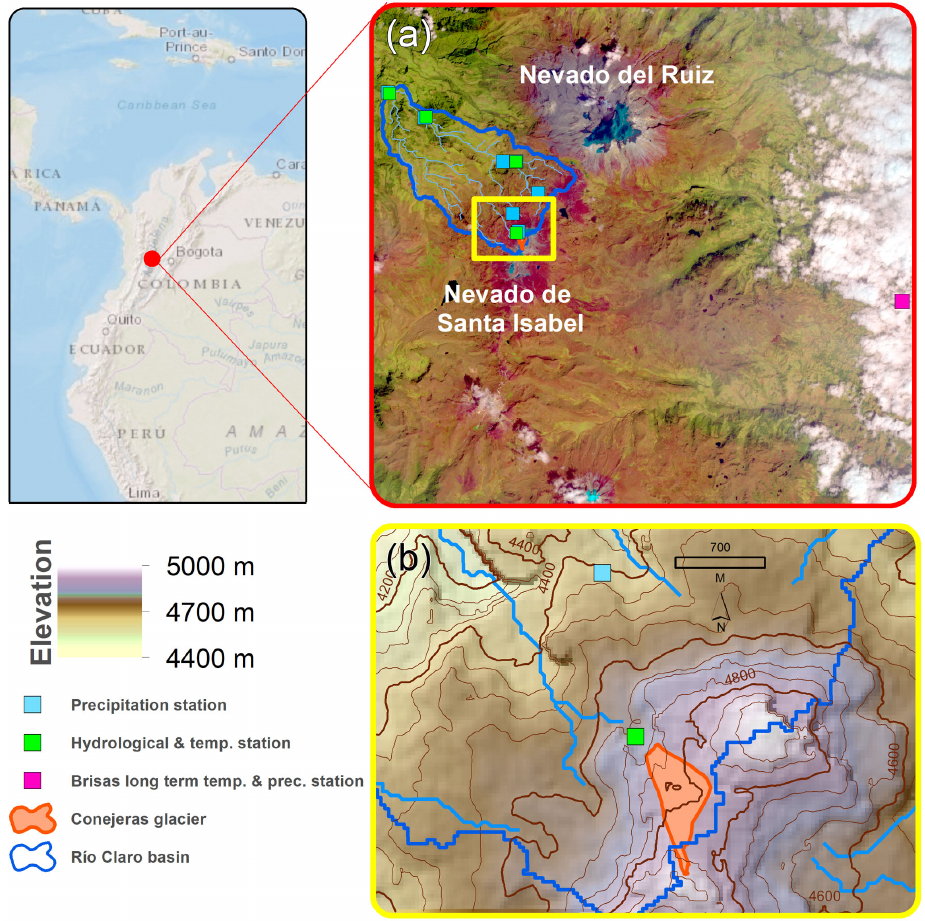
Figure 1. Study area, showing the glaciers of the Parque Nacional Natural de los Nevados, and the Río Claro basin (a) and the Conejeras glacier with hydro-meteorological stations (b)